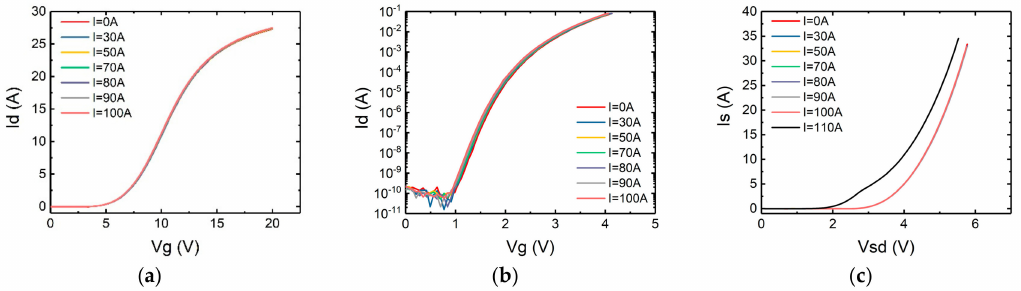
Figure 9. ( a ) Transfer characteristic, ( b ) sub-threshold swing characteristics, ( c ) forward conduction characteristics of the body diode of C2M0160120D after each surge